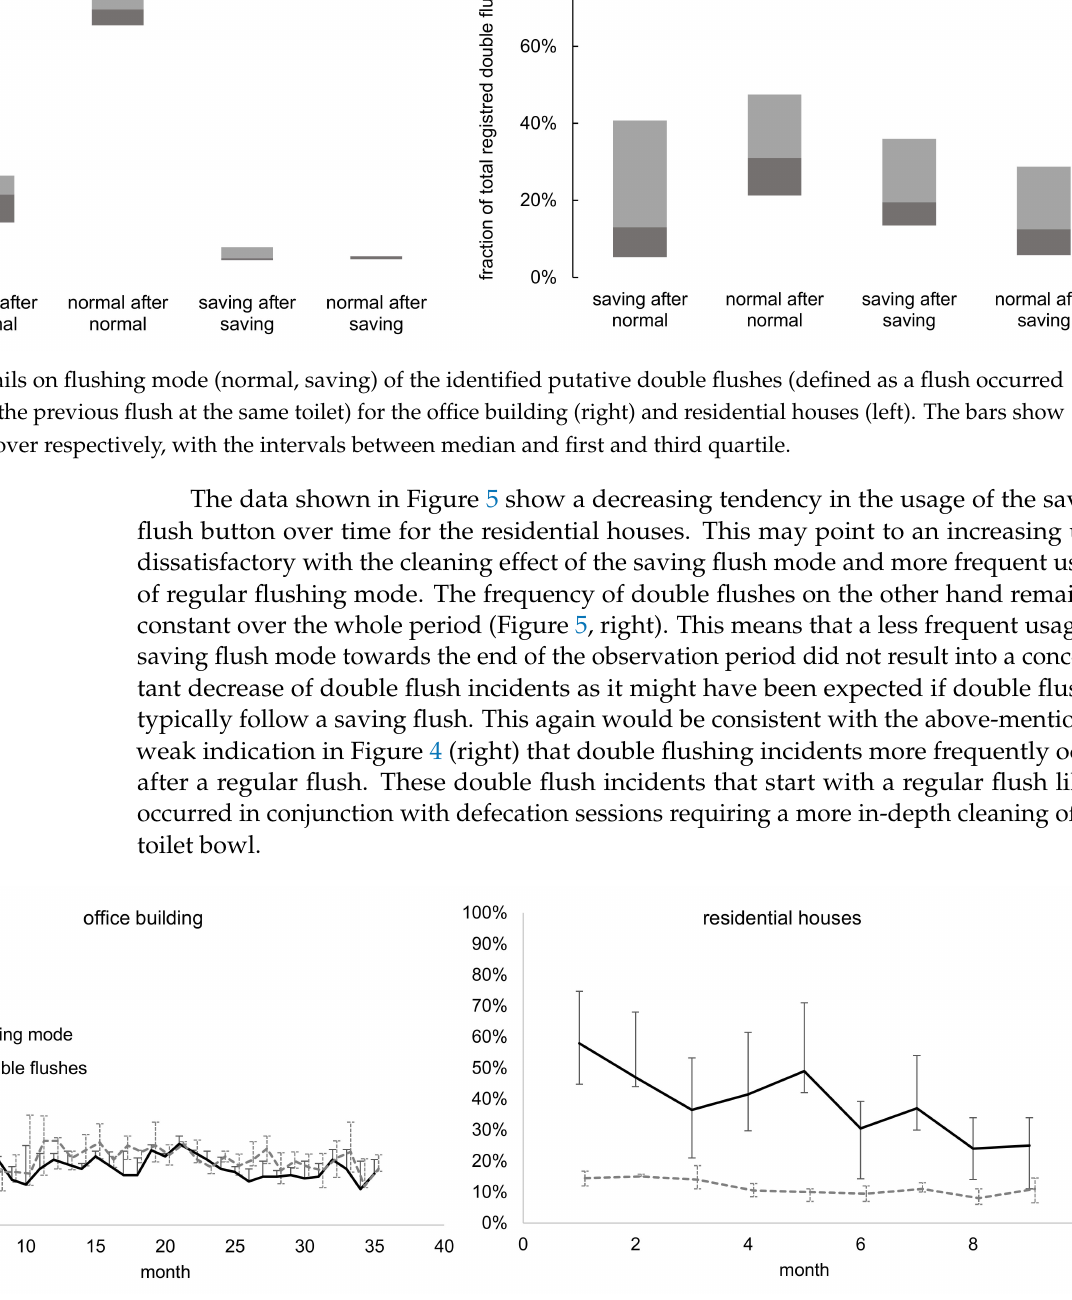
Figure 5. Development over time for fraction of saving mode flushes and fraction of double flushes on the total registered number of flushes. The curves display for each month median values over data gathered from 6 and 10 toilets for the office building and residential houses, respectively. Variation is indicated by the error bars based on the interval between first and third quartile of these monthly data